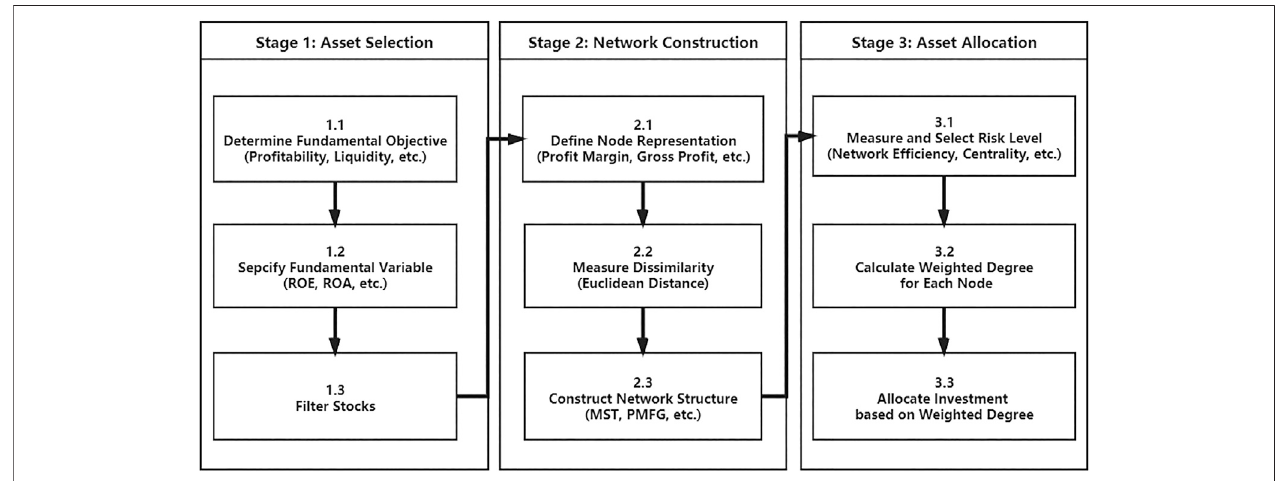
FIGURE 1 | Flowchart for Portfolio Optimization under Fundamental Network Framework. Two empirical examples are speci fi ed in Table 2